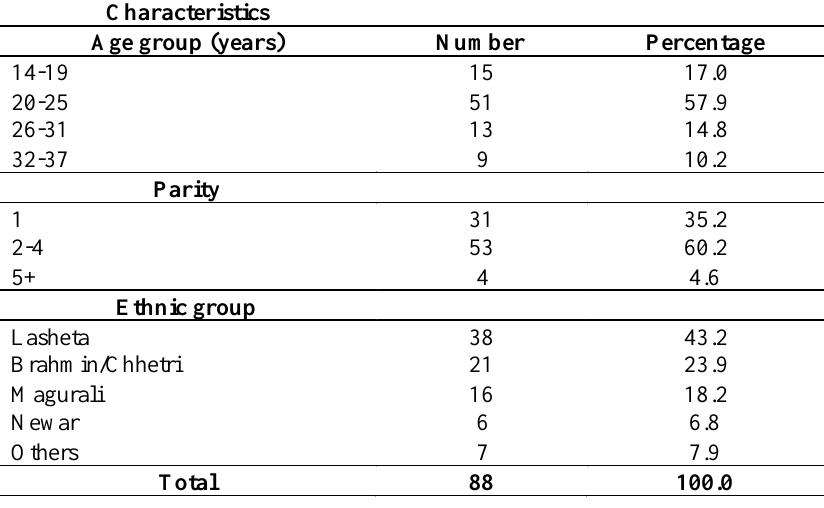
Table I : Demographic characteristics of the women